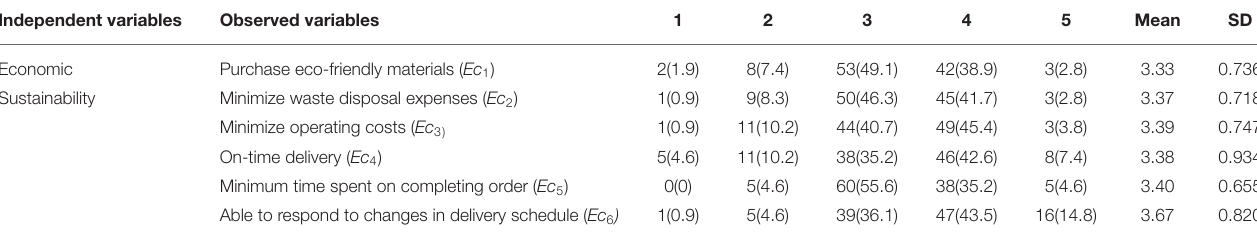
TABLE 8 | Responsiveness to the social sustainability of palm oil millers. Independent variables